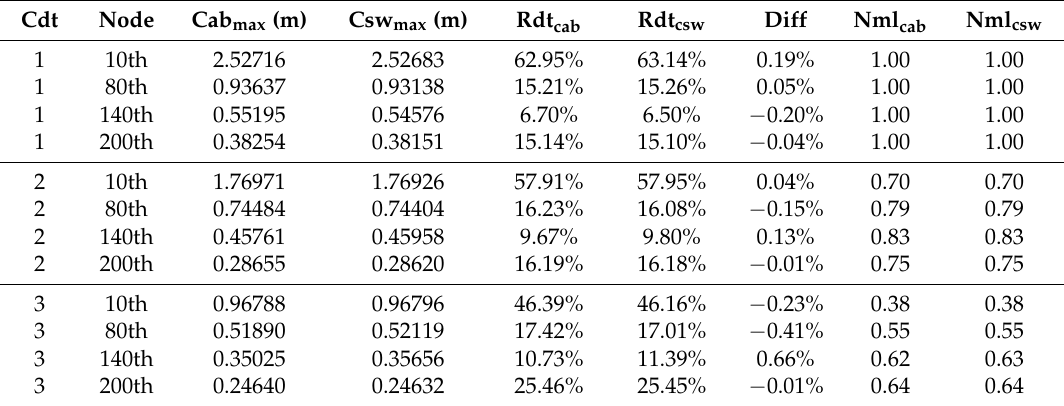
Table 10. Reduction, difference and normalized values of node’s minimum response.